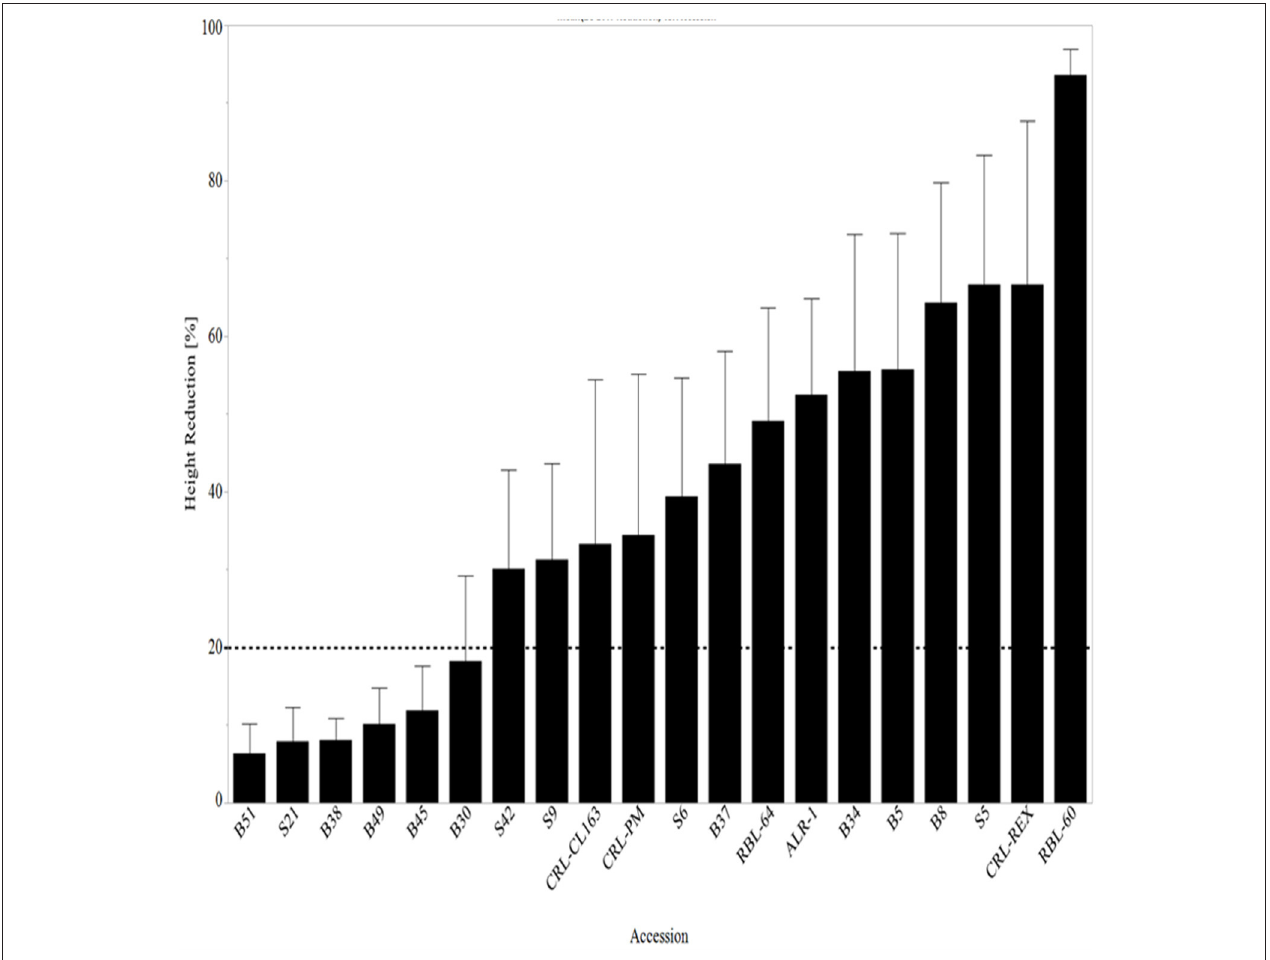
FIGURE 6 | Mean height reduction 28 days after complete submergence stress treatment arranged from lowest reduction to the highest reduction in height. The line at 20% represents all lines with ≥ 20% reduction in height. RBL, Rice breeding line; CRL, cultivated rice line.